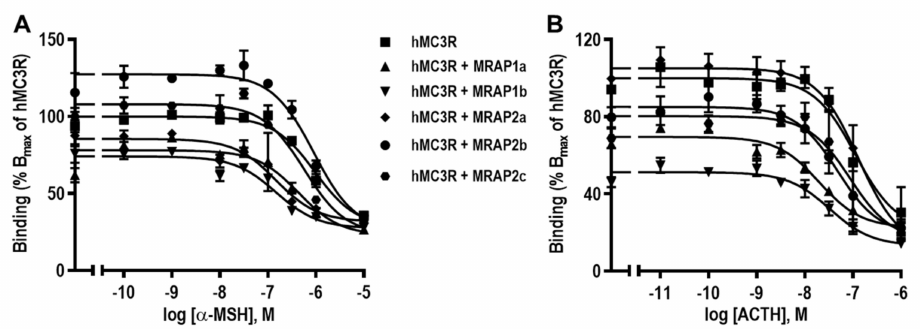
Figure 3. The ligand binding properties of hMC3R regulated by hMRAP1s or hMRAP2s to α - MSH ( A ) and ACTH ( B ). HEK293T cells were transiently transfected with hMC3R with or without hMRAP1a, hMRAP1b, hMRAP2a, hMRAP2b or hMRAP2c plasmids (1:5), and the binding